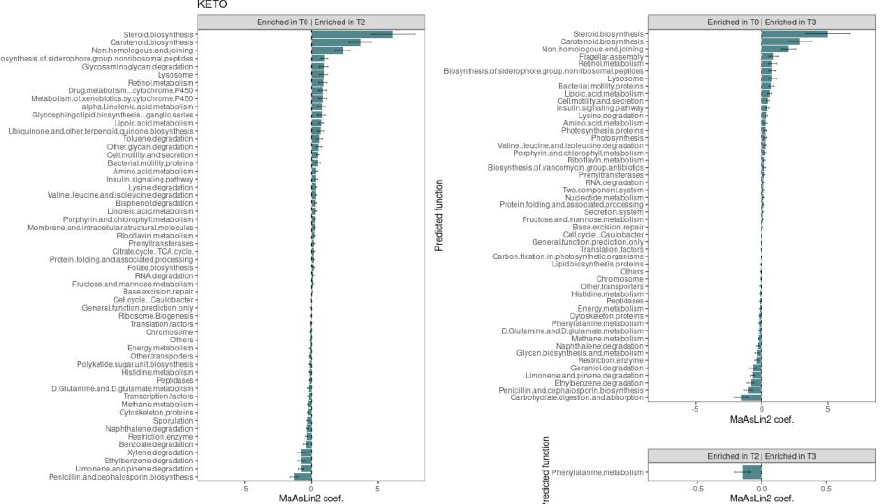
Figure 10. Changes in gut microbiota predicted function abundances between time points for each diet. Each subplot concerns a comparison between time points (T0 vs. T2, T0 vs. T3, or T2 vs. T3). Statistical significance was evaluated by running a Generalized Linear Mixed-effects Model with MaAsLin2. Effect size is represented by the MaAsLin2 model coefficients and respective standard errors. Only predicted function abundance changes at p ≤ 0.05 and q ≤ 0.25 are considered statistically significant. KETO = 6 patients who followed a very-low-calorie ketogenic diet (VLCKD). Samples were analyzed at baseline (T0), after two months (T2), and after three months (T3) of nutritional intervention.